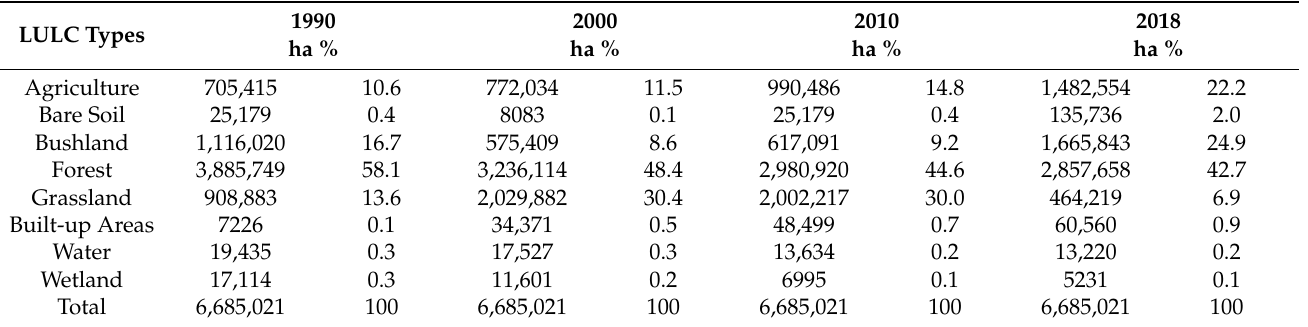
Table 6. The overall areas of individual LULC classification in the years 1990, 2000, 2010, and 2018 in the WRB.